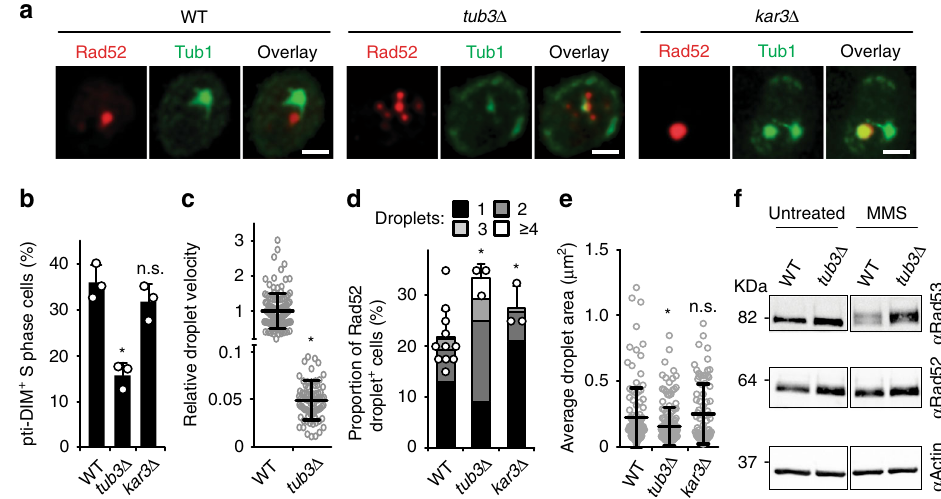
Fig. 4 pti-DIMs promote genome-stabilising clustering of Rad52 droplets. a – f Live-cell microscopy shows that the pti-DIM-compromising tub3 Δ ( a , b ) lowers droplet velocity ( c ), increases droplet numbers ( d ) and decreases droplet size ( e ), while western blotting shows Rad53 hyper-phosphorylation ( f ). kar3 Δ served as control. Quanti fi cations represent the mean ± s.d.; * P ≤ 0.0004 in χ 2 ( b , d ) and Mann – Whitney U ( c , e ) tests. n = 3 independent experiments, 120 cells total ( b ). n = 127 (WT) and 80 droplets ( tub3 Δ ) over 6 independent experiments ( c ). n = 11, 440 cells (WT), n = 3, 120 cells each ( tub3 Δ , kar3 Δ ) ( d ). n = 123 (WT), 169 ( tub3 Δ ), and 83 ( kar3 Δ ) ( e ). Scale bars, 1 µ m. Source data are provided as a Source Data fi le. Microscopy . All experiments were done on logarithmic phase cells 16 . For drug Kar3delTest (CCAATAAGAGGGTAATGGAG) and Tub3delTest (GTGCCAGA GCAGAGCATATCG). Reverse primer used to test both KAR3 and TUB3 deletion treatment, cells were treated with 0.03% MMS or 50µg/mL zeocin for 1h. For through integration of the hygromycin resistance gene is Scp164 (CTTTGTAGAA combined MMS and 1,6-Hexanediol treatment, cells were treated with MMS for ACCATCGGCG). Forward and reverse primers used to test for C-terminal tagging 1 hr, pelleted and washed with ddH 2 O, then re-suspended in SC drop-out medium of NUP49 with GFP-KanMX are NupGKanIntF (CACAGCAGATCTAGGTT with 5% 1,6-Hexanediol and digitonin [2 µg/mL] for 1 h before imaging. Controls CATCC) and JT57 (GACTGTCAAGGAGGGTATTC). were treated similarly with digitonin. Small-budded S-phase cells in asynchronous NATURE COMMUNICATIONS| (2020) 11:695